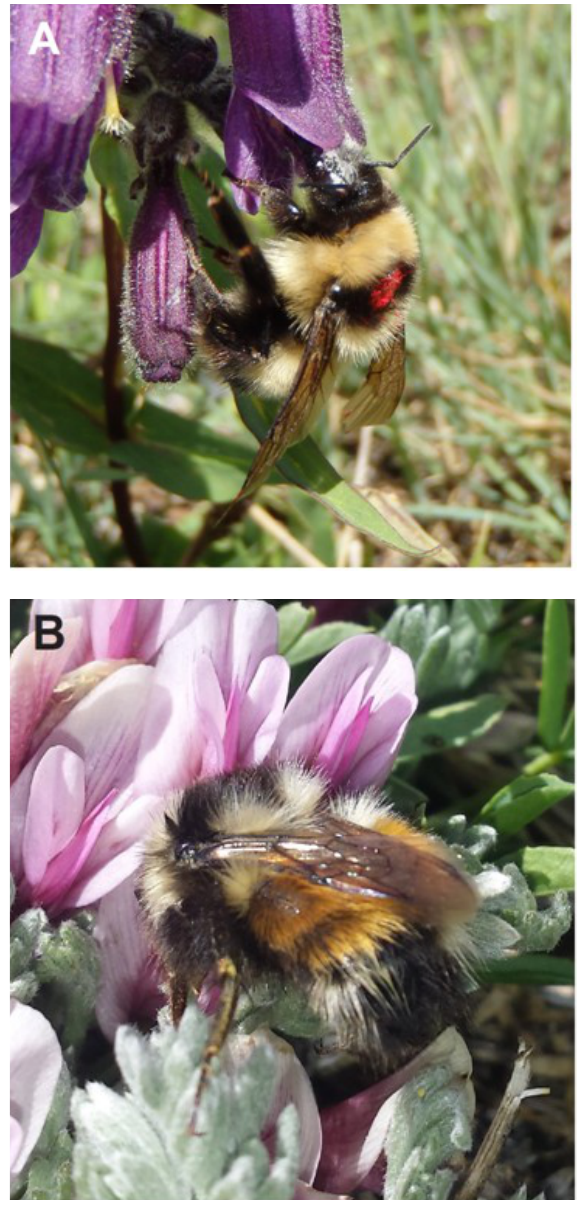
Figure 2. Bombus balteatus (A) and B. sylvicola (B) studied in (M-S15) are described as uncommon (A) and rare (B) species (Koch et al. 2014). Rapid adaptation to climate change could stabilize their populations if its demographic cost is low and future warming of alpine regions slows. Photographs by Eric Rayfield and Nicole Miller-Struttmann,